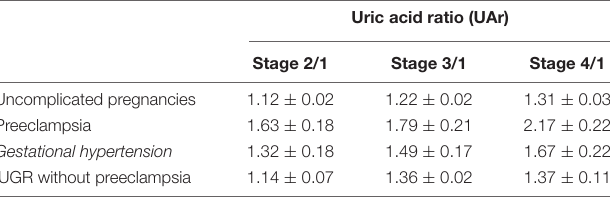
TABLE 4 | Uric acid ratio (UAr) in uncomplicated pregnancies, preeclampsia, gestational hypertension, and IUGR without preeclampsia.